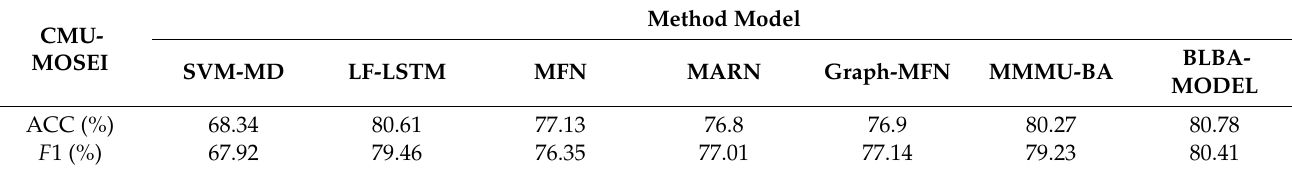
Table 2. Comparative experimental results of different